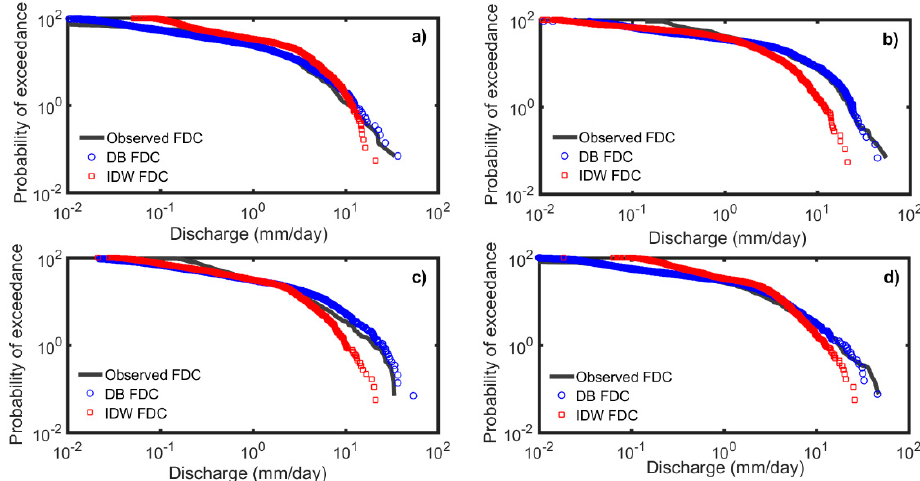
Figure 3. Comparison of observed and modelled FDCs for four sample basins: Ambabal ( a ), Honnali ( b ), Jagdalpur ( c ), and Kosagumda ( d ). It can be observed that for each of the four basins the DB model is better than the IDW model in predicting FDC.